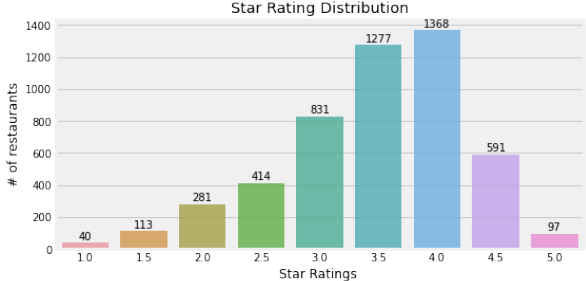
Figure 3. Star rating (1–5) distribution among a number of